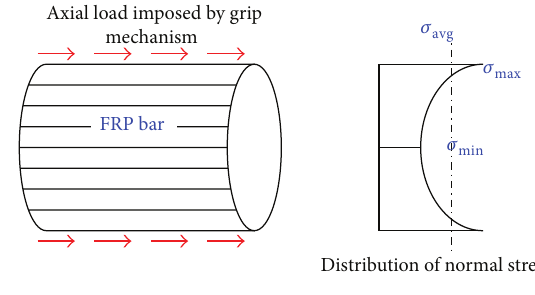
Figure 3: Shear lag.